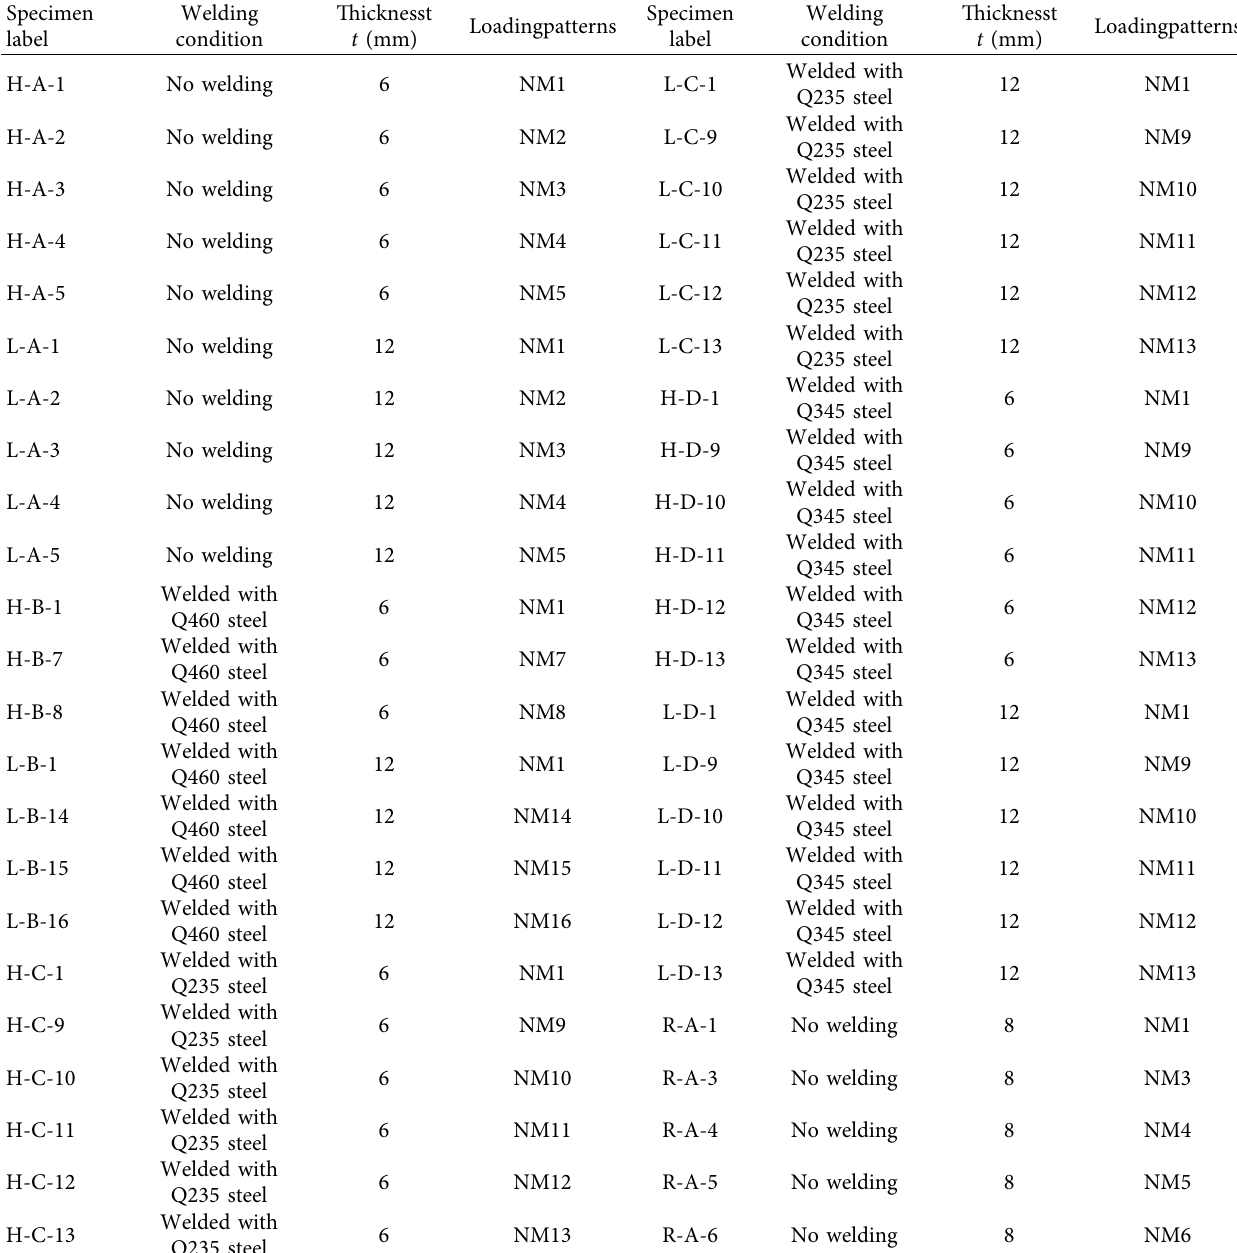
Table 3: Specimen